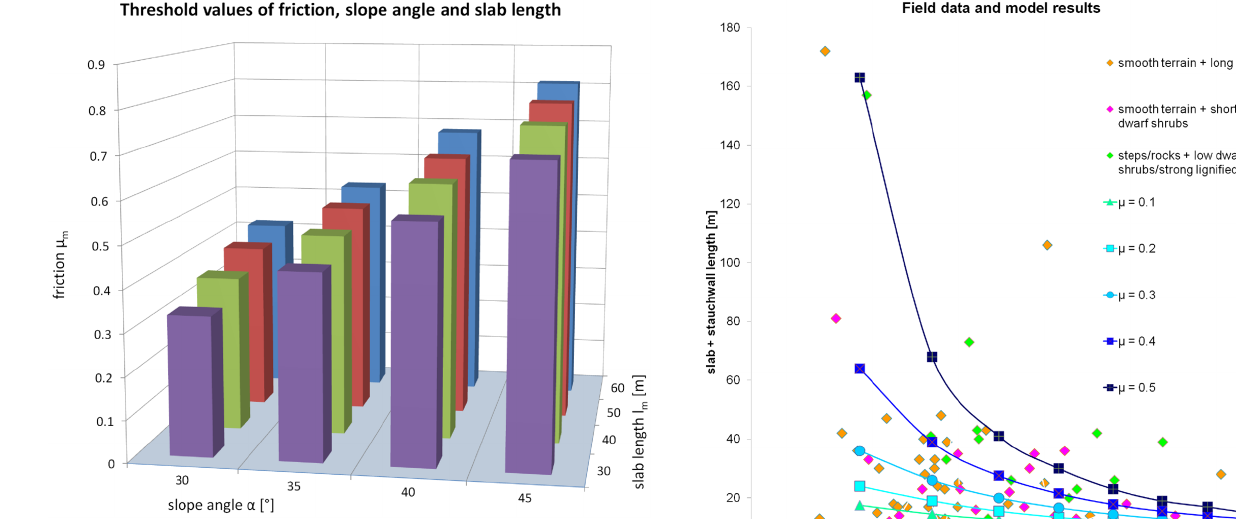
Figure 9. Three-dimensional plot showing combinations of fric- tion µ m , slope angle α and slab length l m for a critical strain rate ˙ (cid:15) = 0 . 01s − 1 . The higher the slope angle, the higher the friction µ m must be to prevent a failure of the stauchwall. The larger the slab length l m , the larger the friction µ m must be to prevent failure.